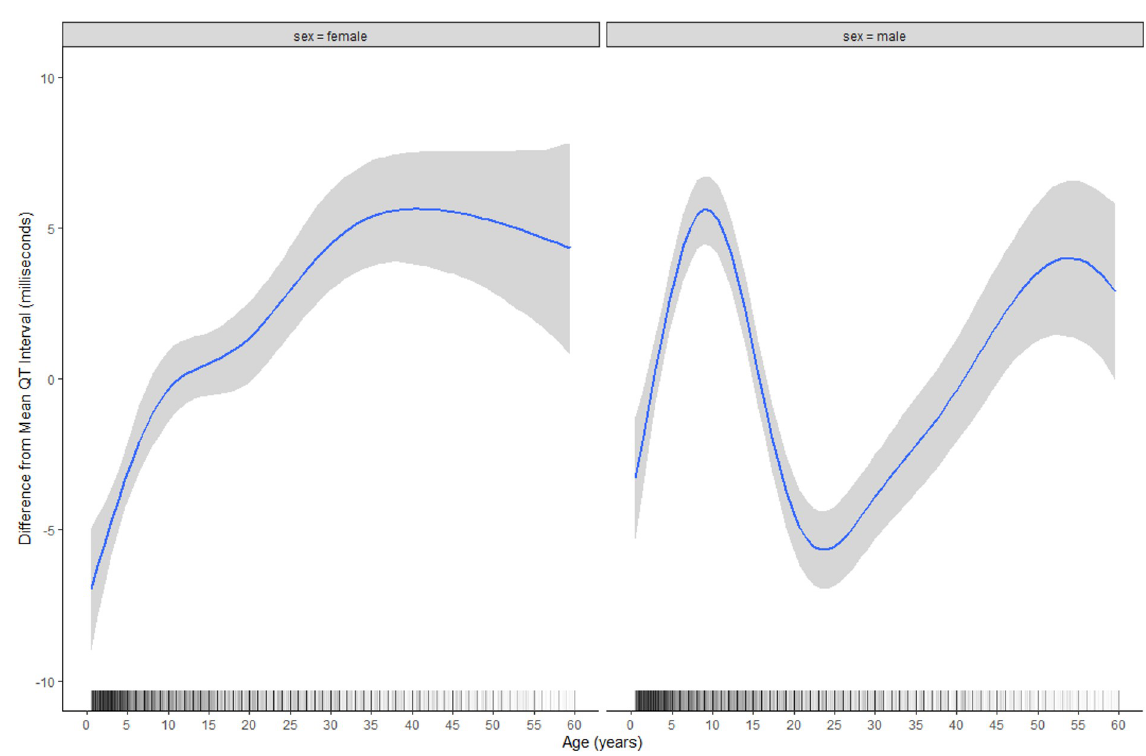
Fig 4. Age, sex, and the QT interval in malaria. Interaction between age and sex, and conditional effect on the QT interval, from a hierarchical generalised additive model adjusting for heart rate/RR interval (as Shaded areas represent 95% CIs, and rug marks represent age distribution of original data points. CI, credible interval.